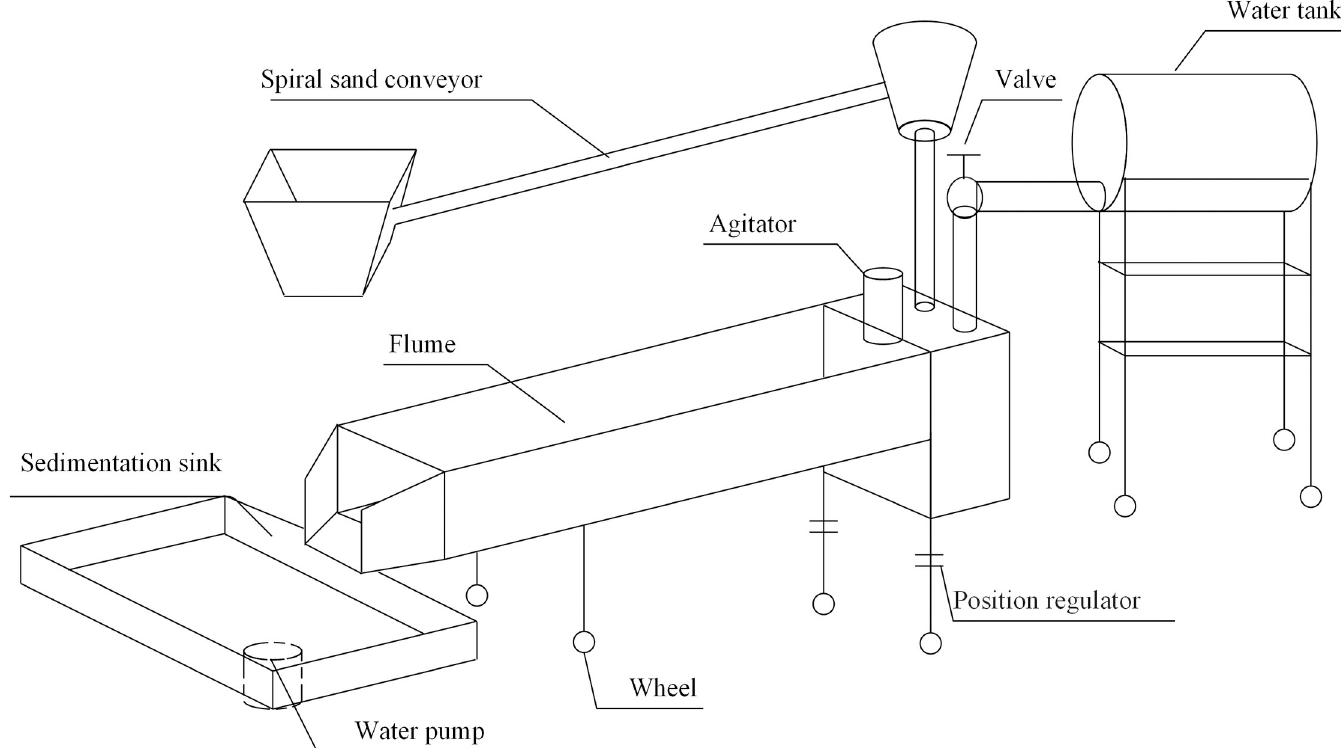
Fig 1. Schematic diagram of the test